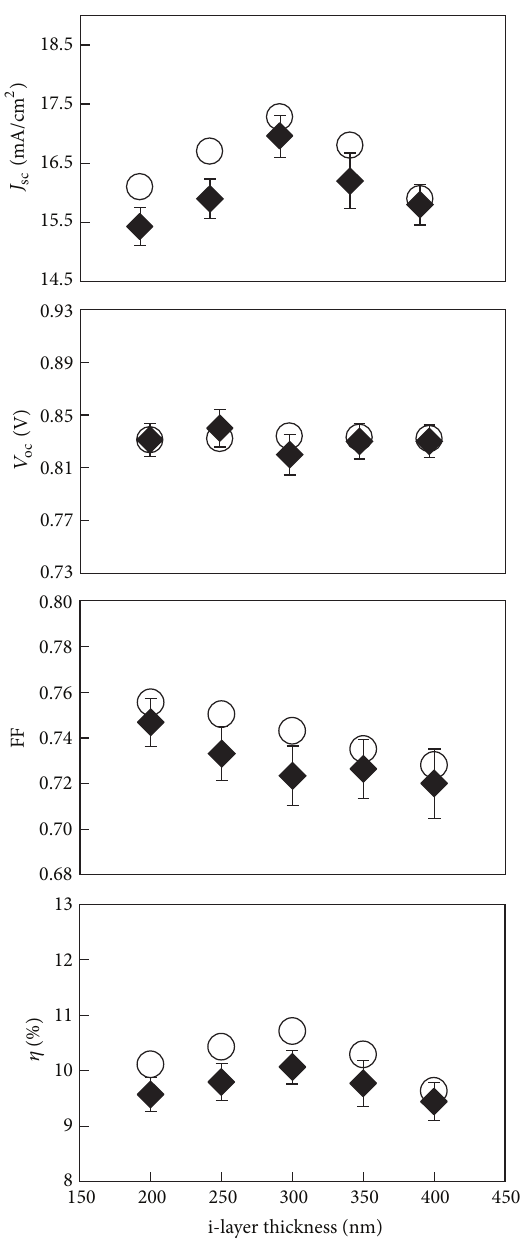
Figure 3: Simulated (open symbol) and experimental (closed symbol) results of external parameters of a-Si:H-like solar cells with different i-layer thickness.